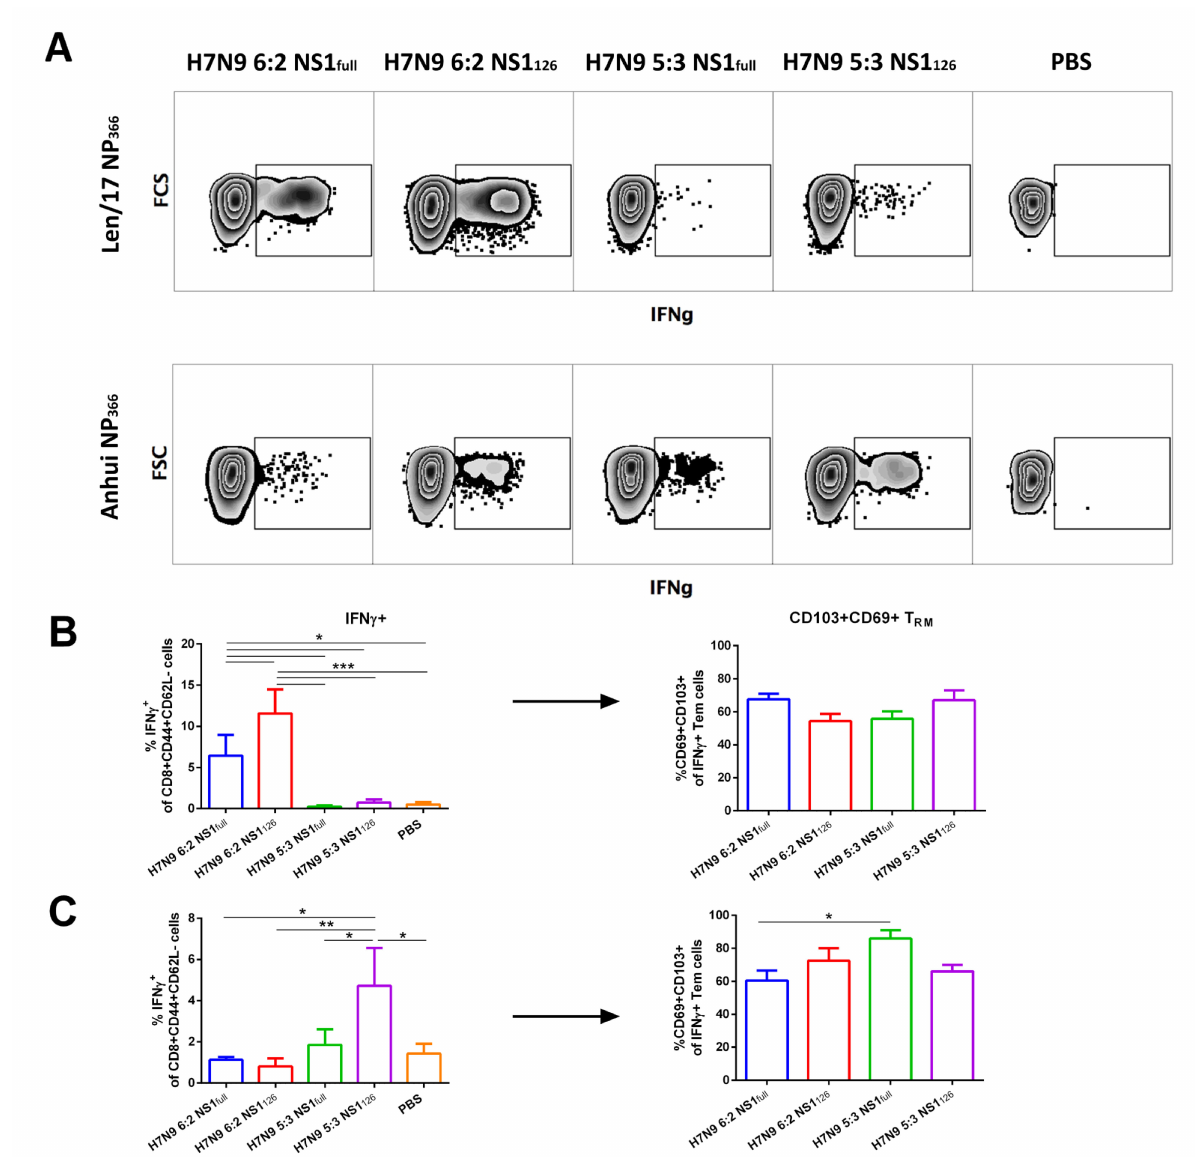
Figure 5. Lung-localized memory T-cell immune responses measured on day 7 after the second immunization. ( A ) Representative flow cytometry plots for IFN γ expression by Tem cells after stimu- lation with Len/17 or Anhui NP 366 peptides. ( B ) Levels of CD8+ Tem cells expressing IFN γ cytokine in response to stimulation with Len/17 NP 366 peptide (left graph) and the T RM phenotypes of those IFN γ -positive effector memory T cells (right graph). ( C ) Levels of CD8+ Tem cells expressing IFN γ cytokine in response to stimulation with Anhui NP 366 peptide (left graph) and the T RM phenotypes of those IFN γ -positive effector memory T cells (right graph). Data were analyzed by one-way ANOVA with Tukey’s post hoc multiple analyses test. *— p < 0.05; **— p < 0.01; ***— p <